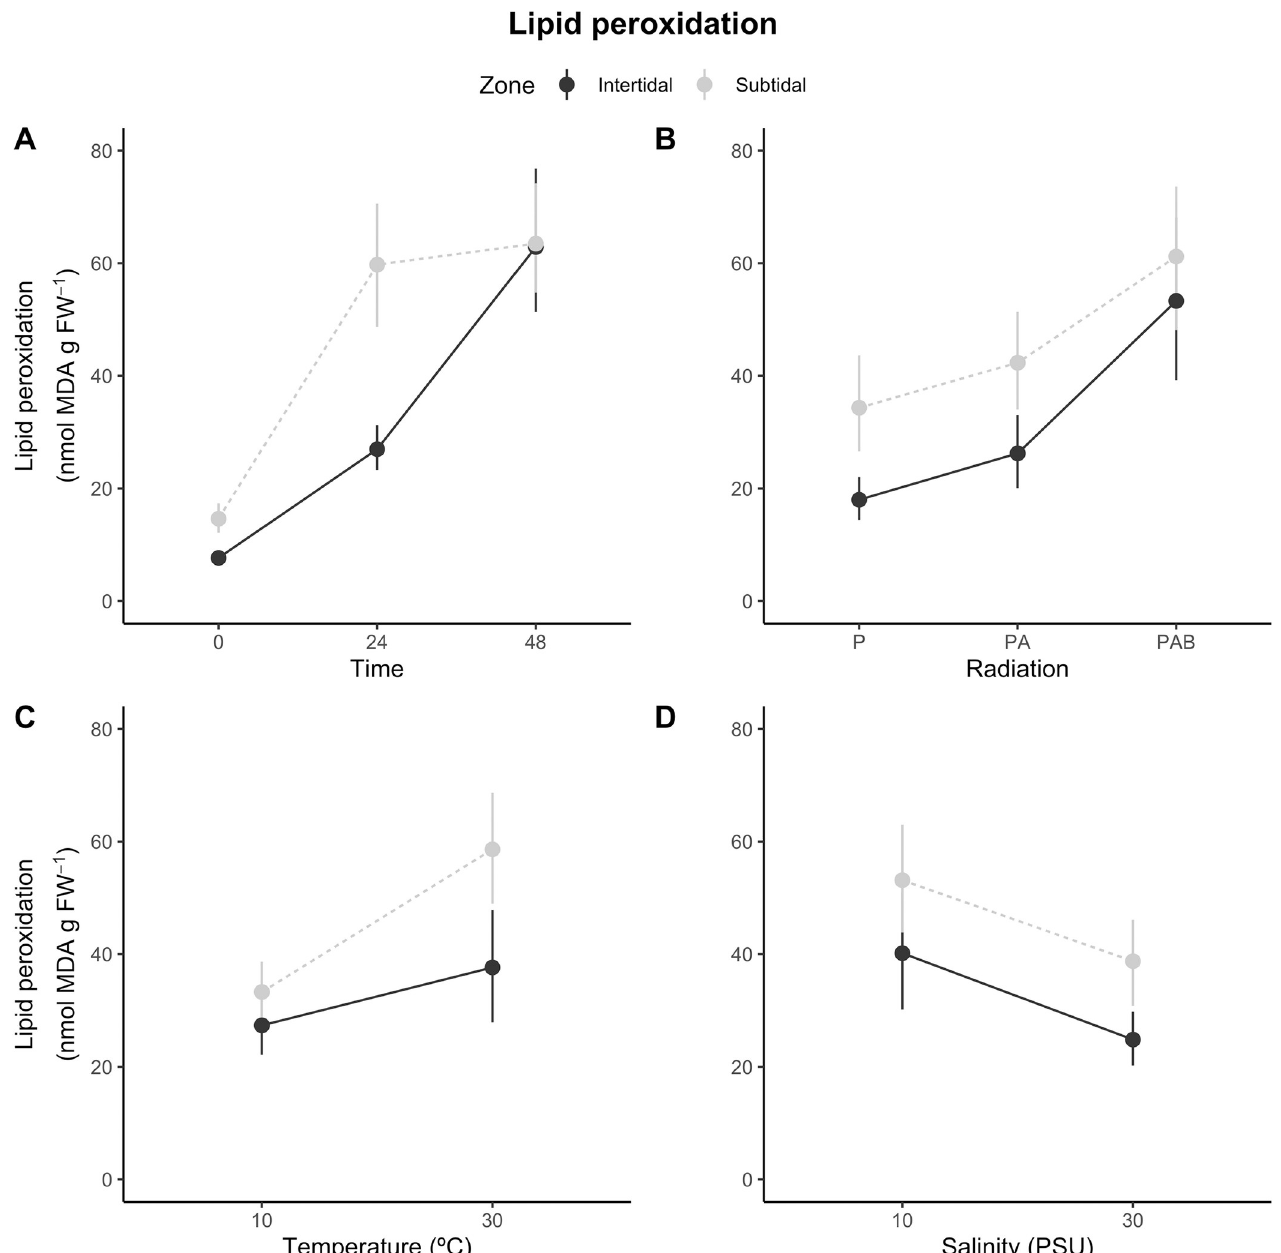
Fig 3. Anthopleura hermaphroditica . Lipid peroxidation: zone-dependent responses of estuarine anemones to variations in (A) exposure time, (B) radiation, (C) temperature and (D) salinity treatments. Values are provided as means ± confidence intervals (n = 4). https://doi.org/10.1371/journal.pone.0279482.g003 Lipid peroxidation levels remained similar between P- and PA-exposed estuarine anemones across both zones, but was significantly higher in the PAB-exposed anemones compared to the other two groups (Table 1). The increase of temperature from 10 to 30˚C triggered zone- dependent estuarine anemone responses (Fig 3; Table 1). Lipid peroxidation in the intertidal estuarine anemones increased 10.3 nmol MDA g FW -1 between the 10 and 30˚C groups. This increase was 2.5-fold greater than for the intertidal organisms than for subtidal estuarine